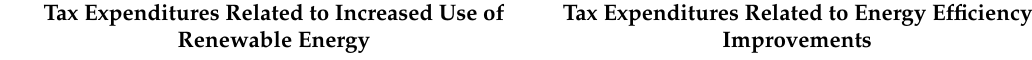
Table 3. Ranking of OECD countries by share of tax expenditures related to the promotion of environmental sustainability in 2020.